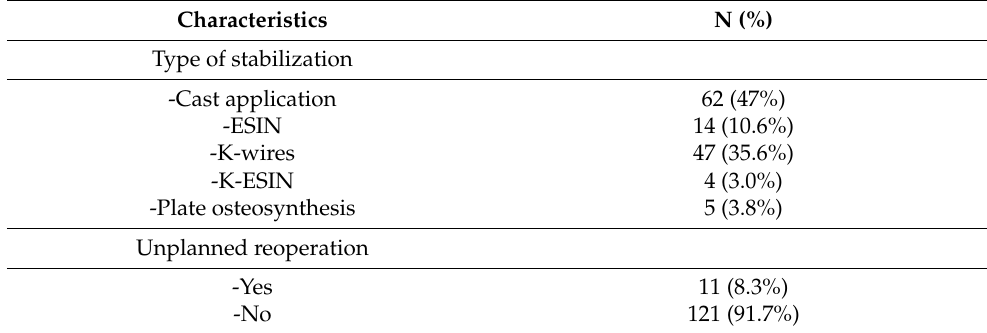
Table 3. Treatment characteristics and unplanned reoperations (n =